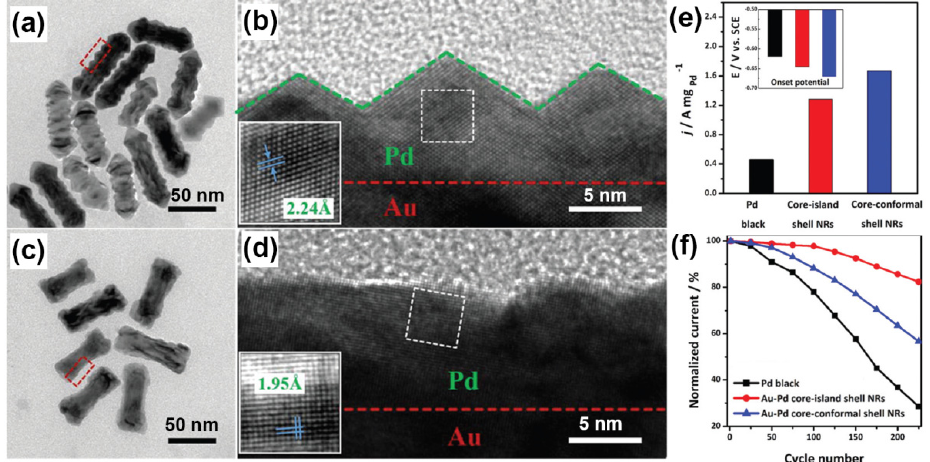
Figure 3. Transmission electron microscopy (TEM) and high-resolution TEM images of ( a , b ) Au@Pd